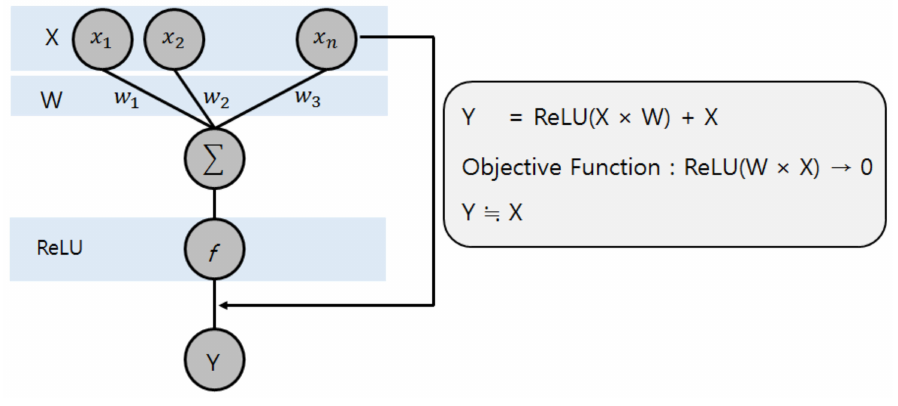
Figure 3. Principle of residual